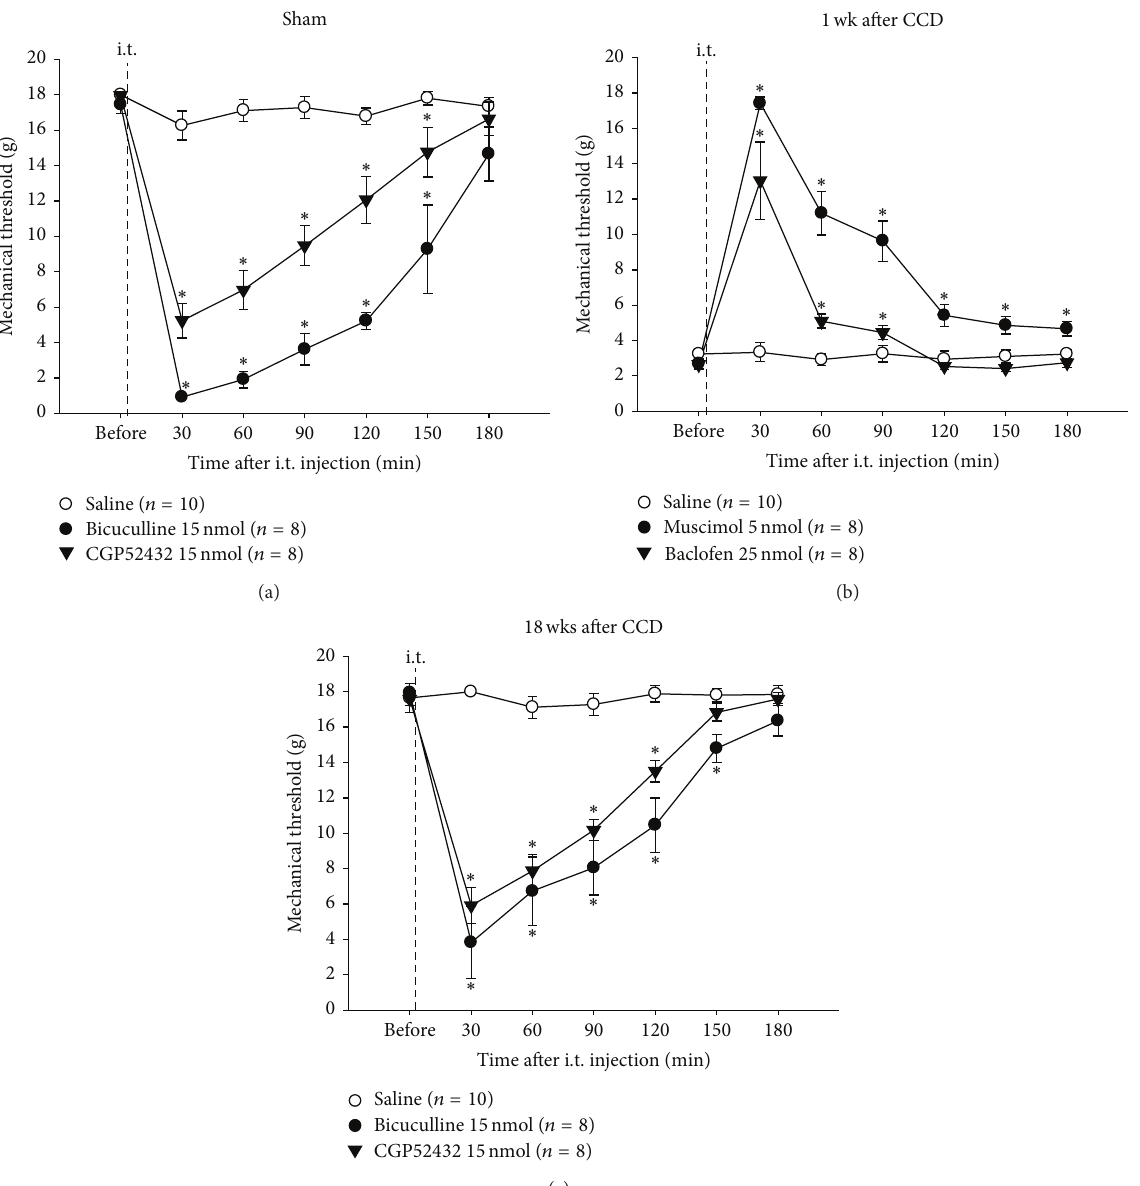
Figure 4: The effects of inhibition or activation of spinal GABA receptors on mechanical sensitivity following CCD. In sham-operated rats (a), an intrathecal (i.t.) administration of bicuculline (15nmol) or CGP52432 (15nmol) produced a decrease in the paw withdrawal thresholds (PWTs)foratleast150 min.On1weekafterCCD(b),ani.t.administrationofmuscimol(5 nmol)orbaclofen(25 nmol)reversedthedecreased PWTs for longer than 90 min. On 18 weeks after CCD (c), bicuculline (15nmol) or CGP52432 (15nmol) resulted in the decrease of PWTs for at least 150min. ∗ 𝑃 < 0.05 when compared with saline-treated